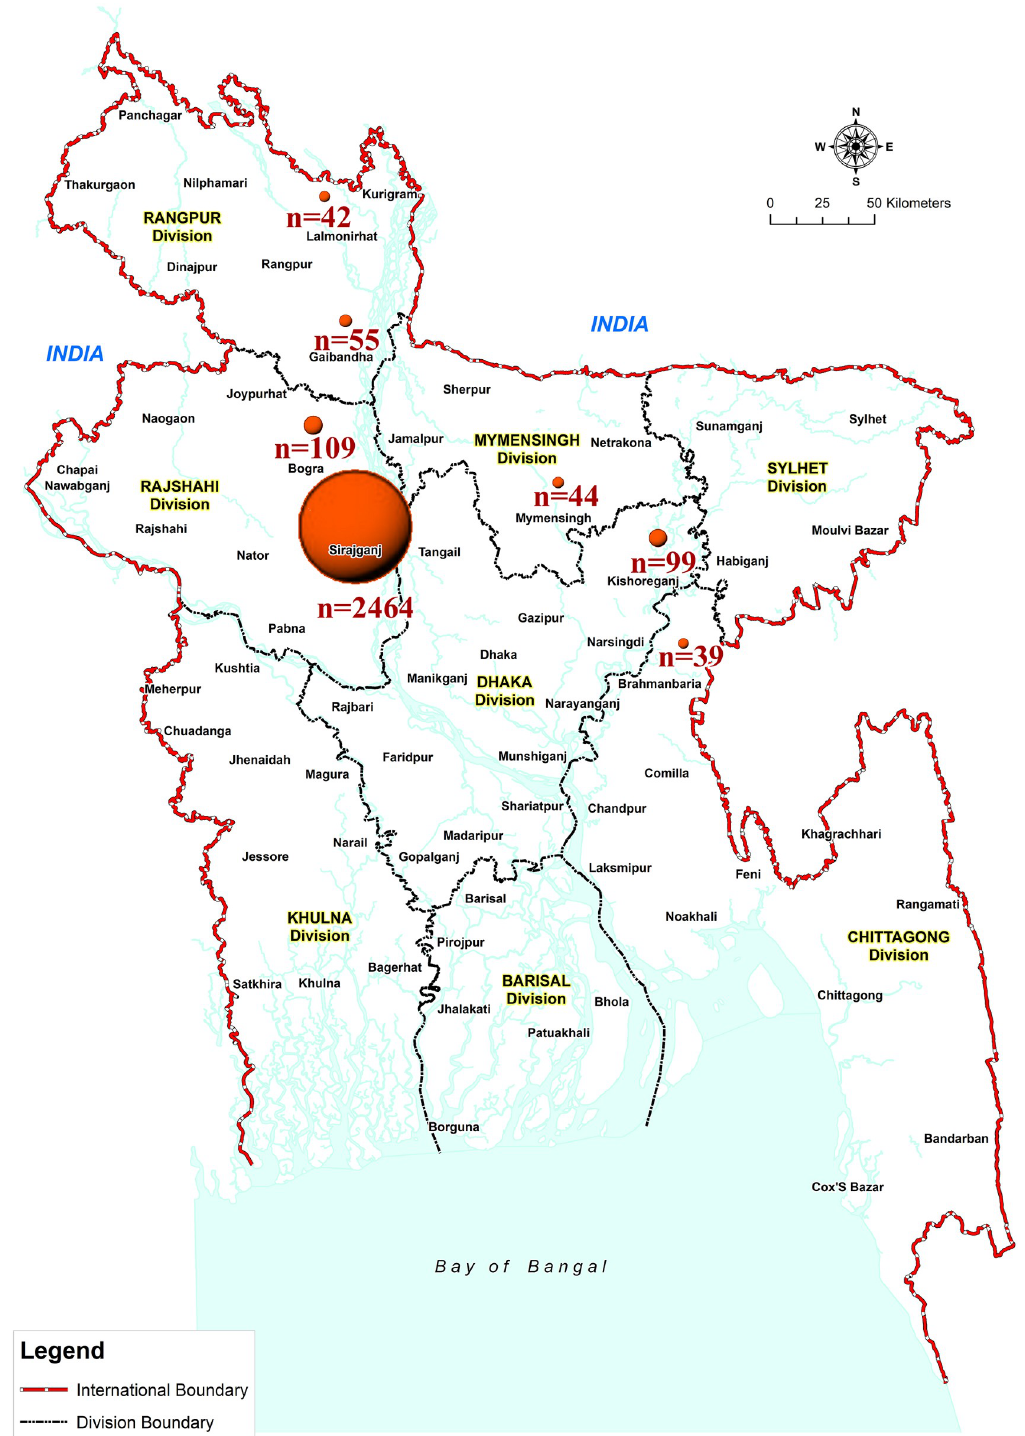
Fig 1. Map of Bangladesh demonstrating the distribution of BCPR-registered children from each district in the study sample. Circle diameters are proportional to the number of children with CP recruited in the study. (This map was produced by the authors using ArcGIS Desktop 10.8